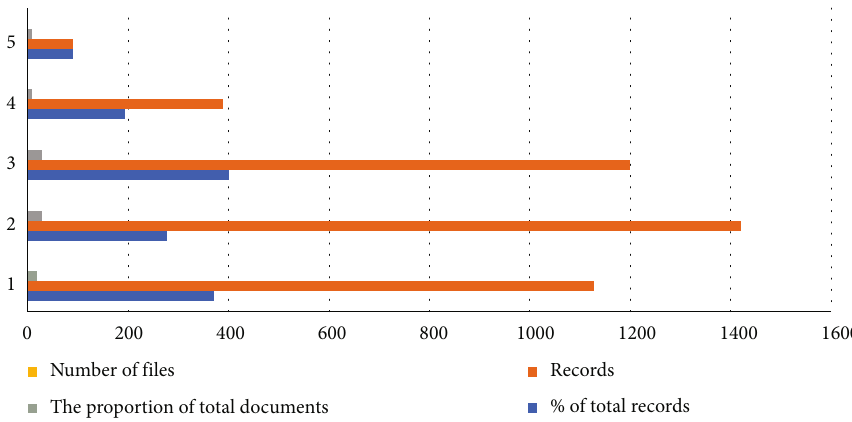
Figure 4: Comparison of the number of records containing abnormal data, the number of fi les, and the number of records.